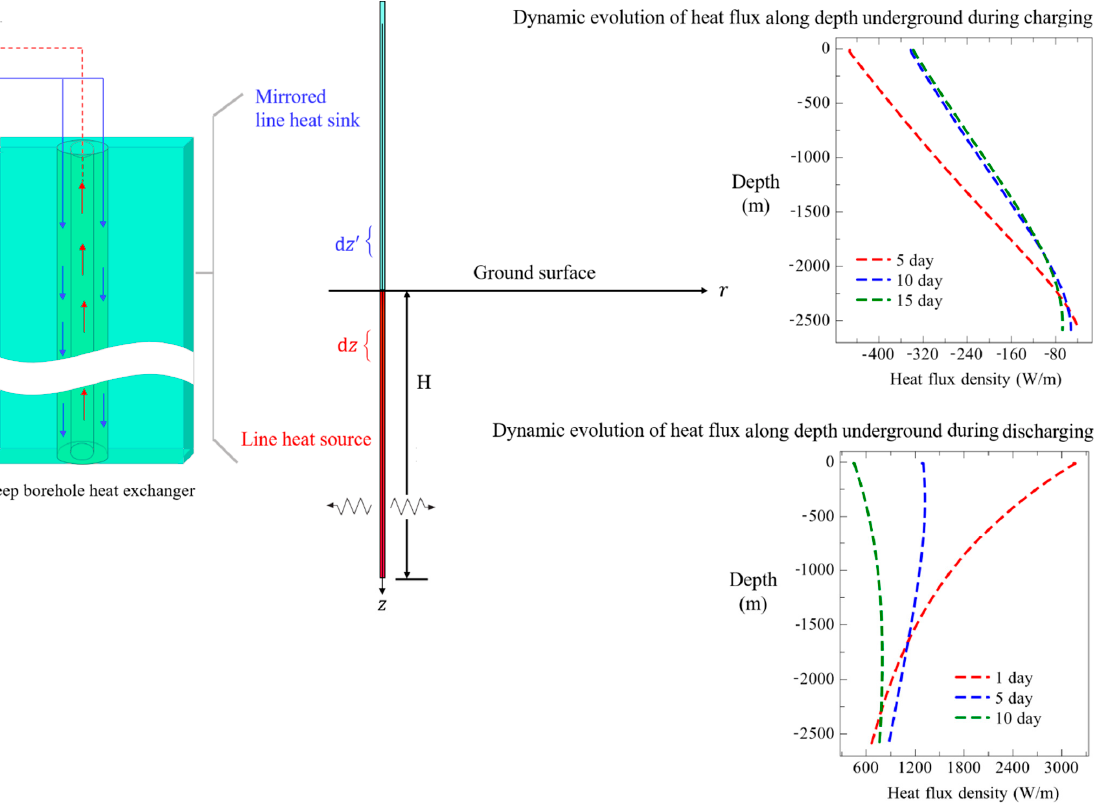
Figure 2. Schematic for spatio-temporal distribution of heat flux density along borehole depth of the deep borehole heat exchanger.